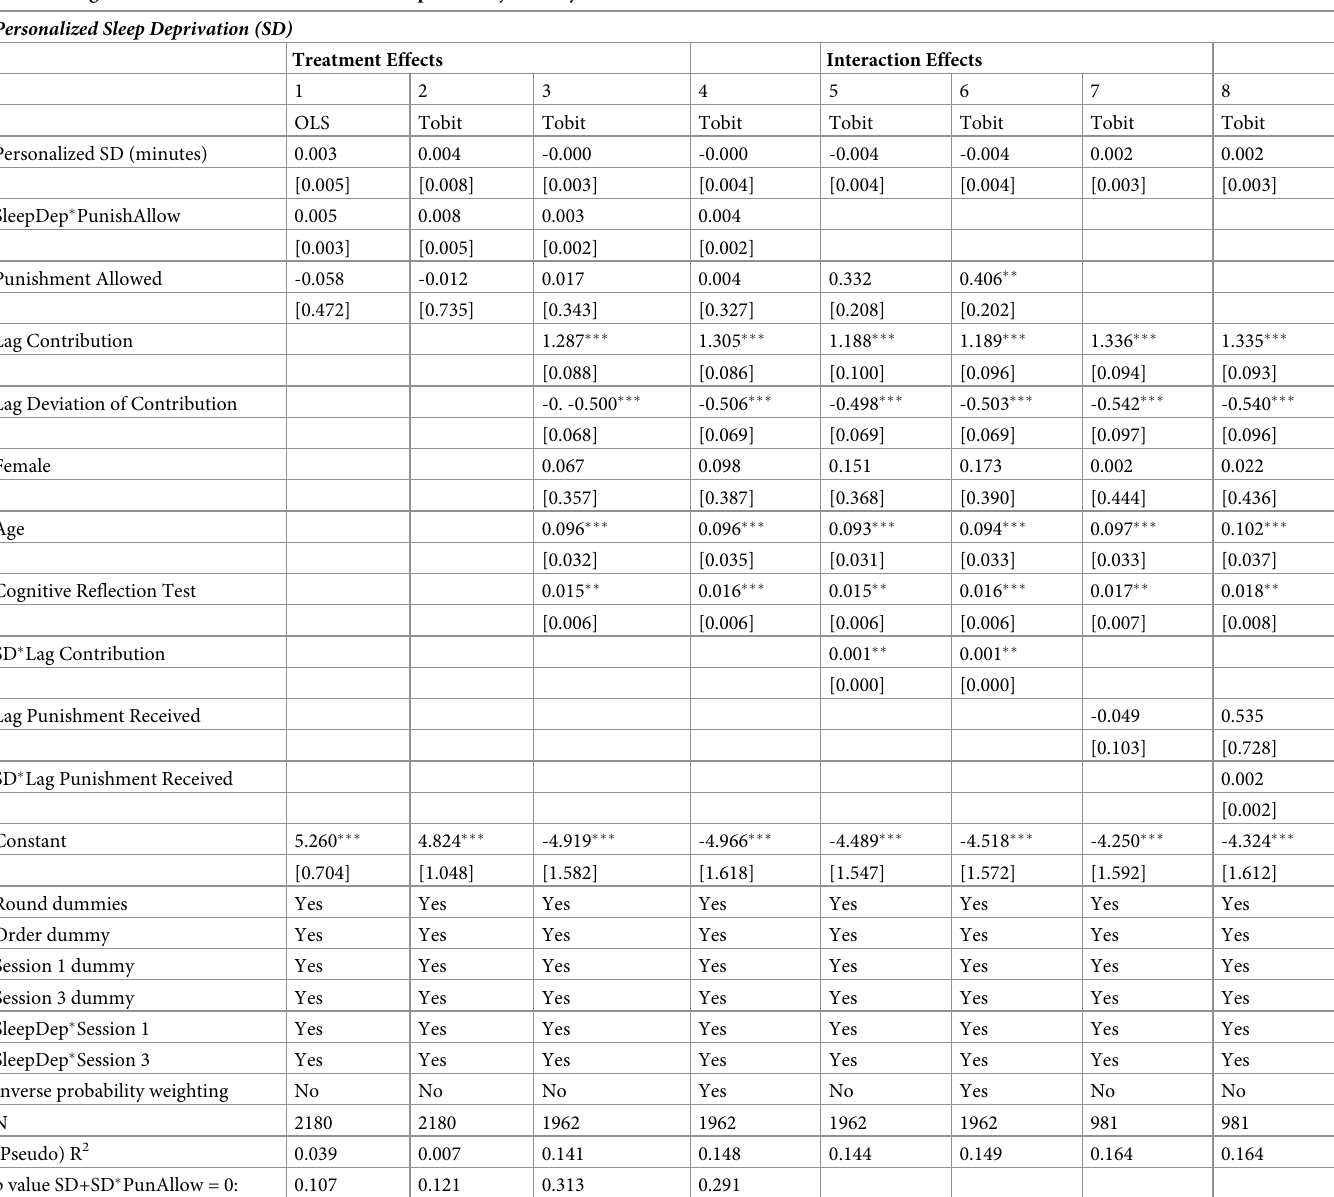
Table 5. Regression results for contributions—compliant subjects